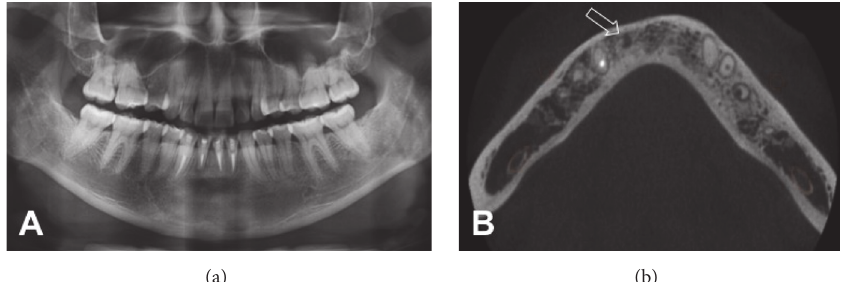
Figure 4: (a) Panoramic radiograph obtained at 4-year follow-up. Bone repair is clearly visible; (b) cone-beam computed tomography image (axial slice), demonstrating bone repair. A possible fibrotic bone scar is visible